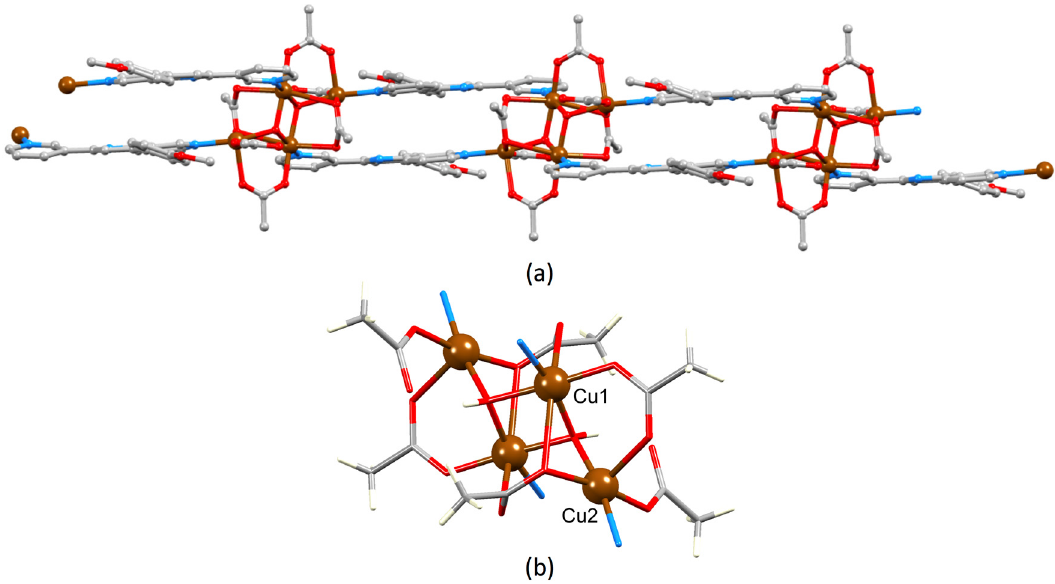
Figure 8. ( a ) Part of one double-stranded chain (solvent omitted) and ( b ) the cluster unit in {[Cu 4 ( µ 3 -OH) 2 ( µ -OAc) 2 ( µ 3 -OAc) 2 (AcO- κ O ) 2 ( 1 ) 2 ] · 2MeOH} n .